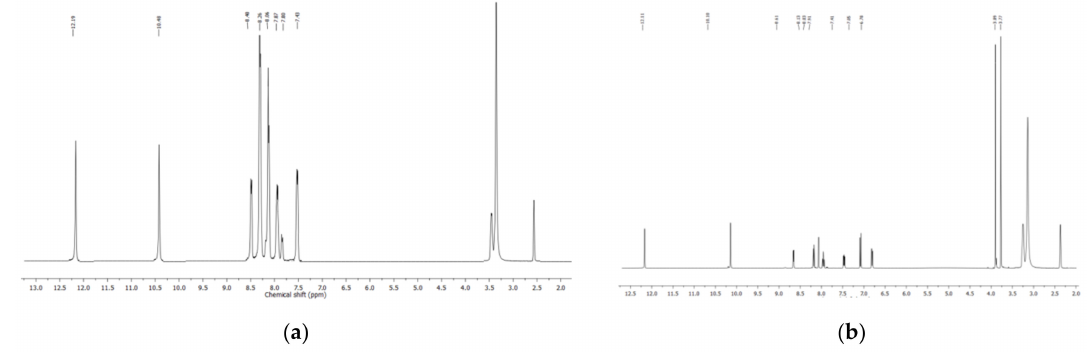
Figure 4. 1 H NMR spectra of C1 ( a ) and C2 ( b ) measured in DMSO-d 6 .